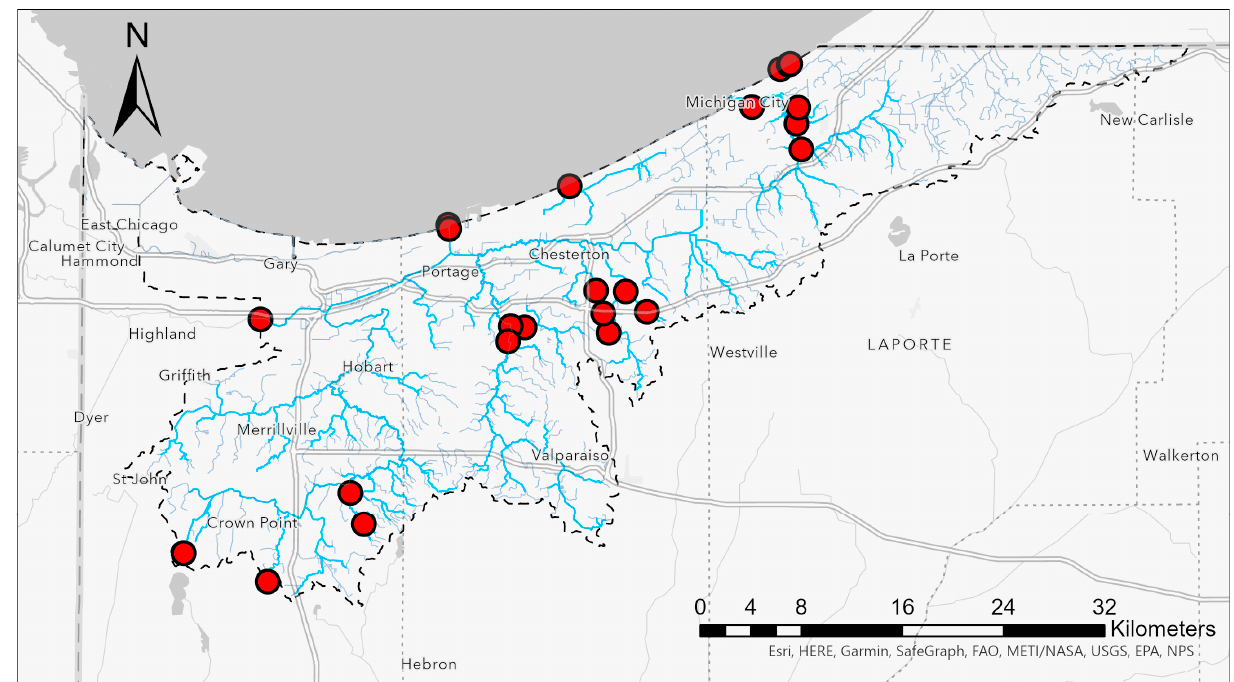
Figure 4. Water samples were collected from lake water and tributary creeks and streams across the Lake Michigan watershed in Indiana. Collection sites are indicated by red dots. The watershed boundary is indicated by a dashed black line.